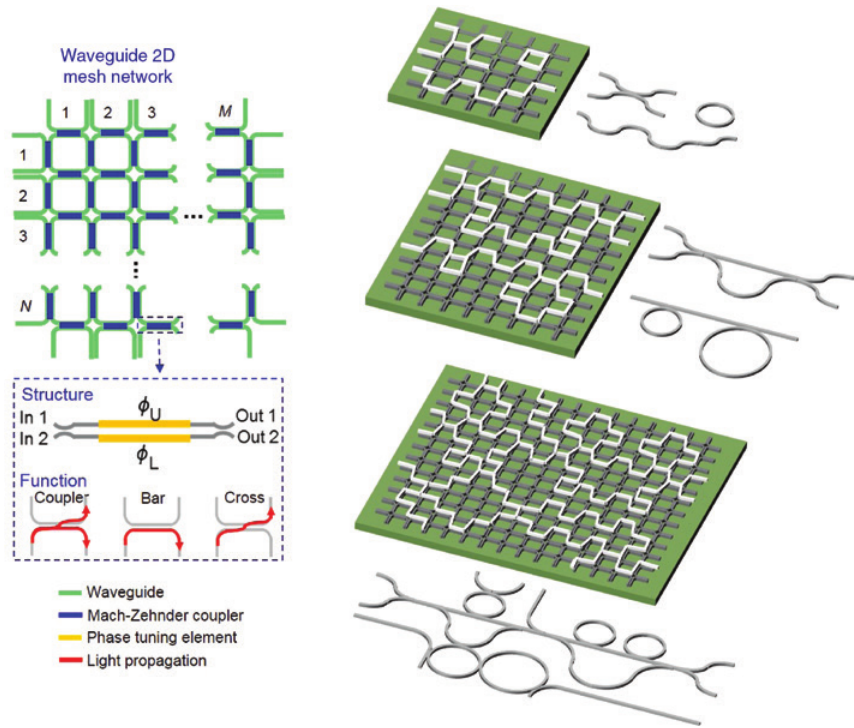
Figure 16: Conceptual design of a programmable optical chip comprising a number of Mach-Zehnder couplers interconnected in a 2D lattice mesh network architecture and examples of implementing different signal processing circuit topologies [45] (Copyright in 2015, Optical Society of